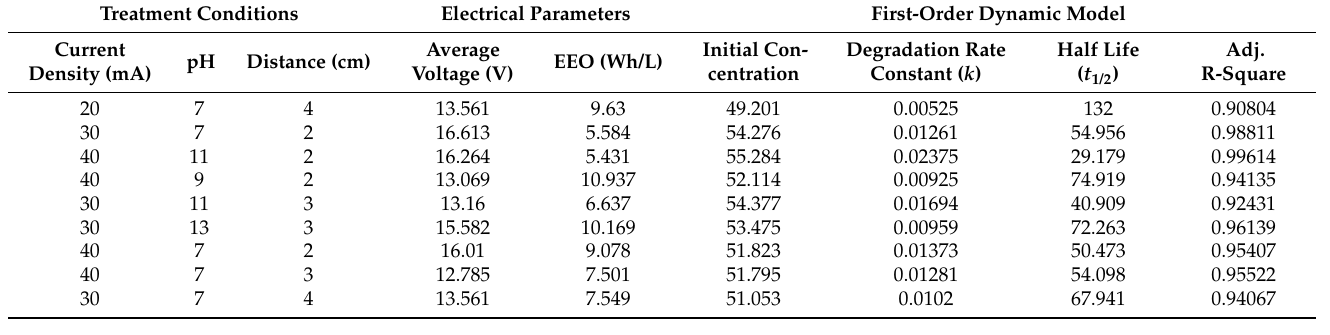
Table 1. The pseudo-first-order kinetic simulation parameters of norfloxacin electrochemical degra- dation with PbO 2 -NF electrode under different operating conditions.